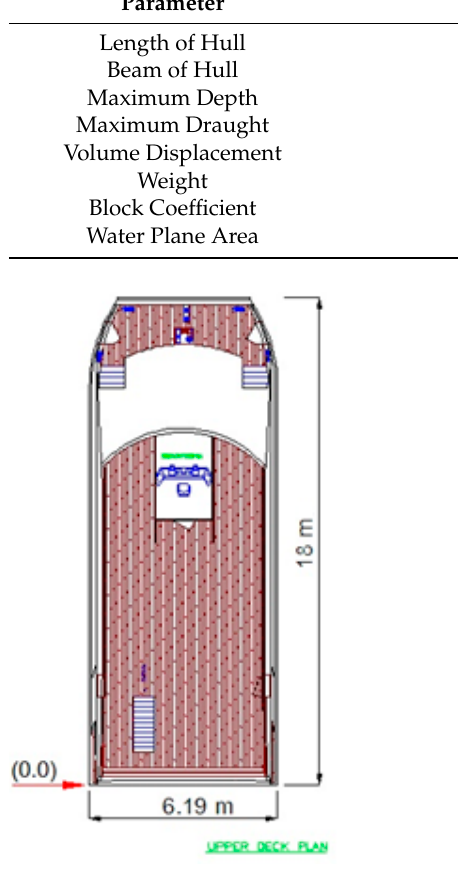
Figure 4. The reference point of the ship system in the top